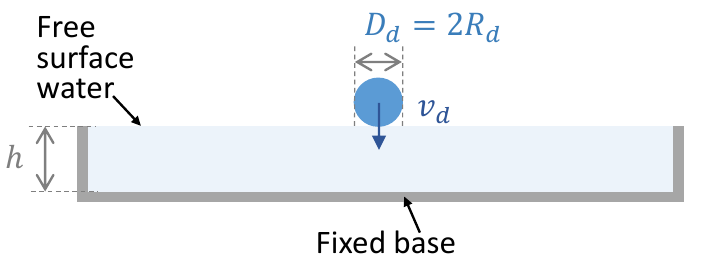
Figure 11. Full spoon model.